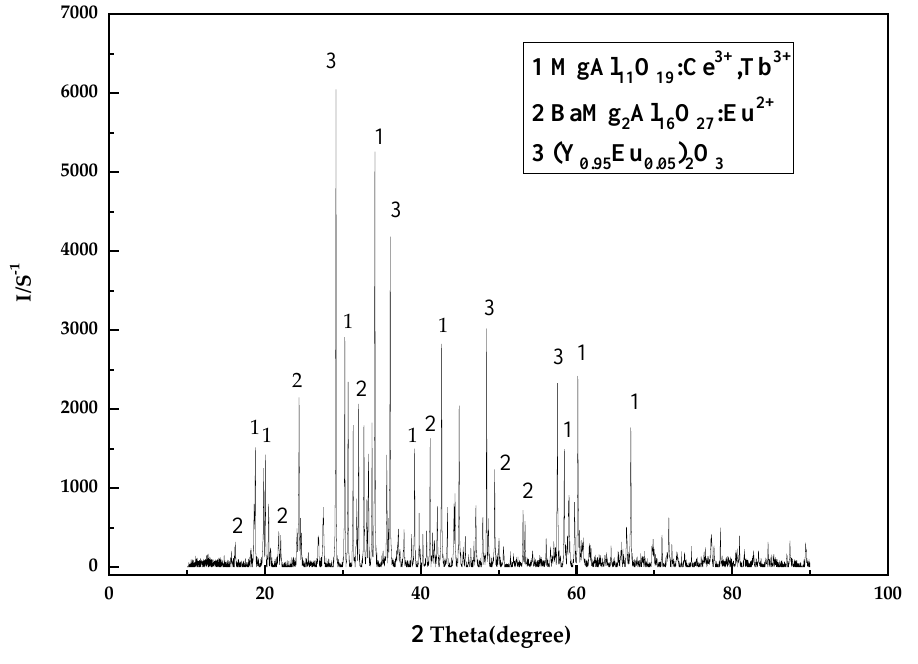
Figure 1. XRD pattern of the raw material. Table 1. Total RE and RE oxide distribution in the raw material. Element